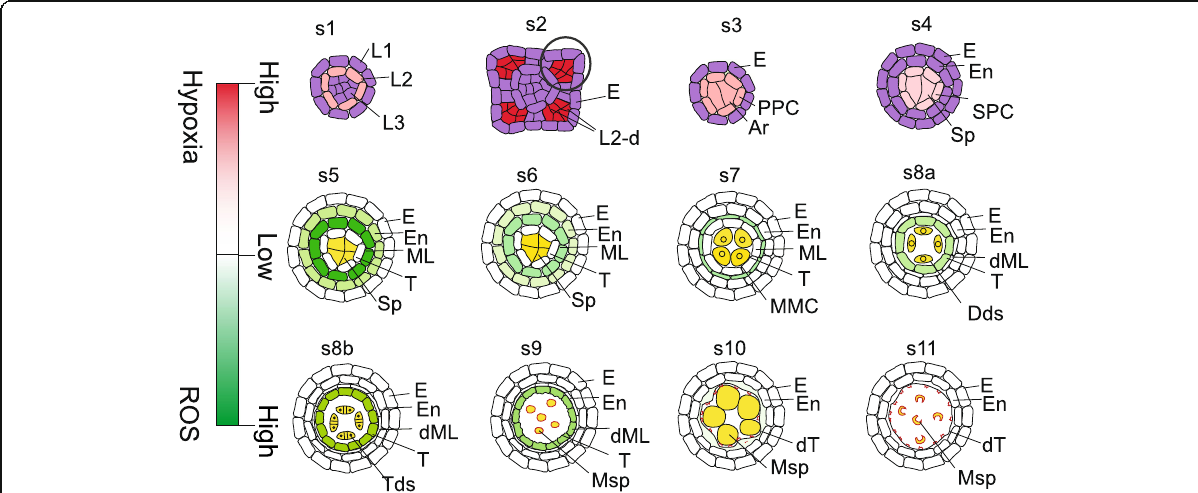
Fig. 1 Redox status during anther development. Red color shows the gradient of hypoxia status; green color shows the gradient of ROS status; white color shows undetectable level of ROS by DAB staining; purple color shows no discussion about the redox status; yellow color shows the germinal